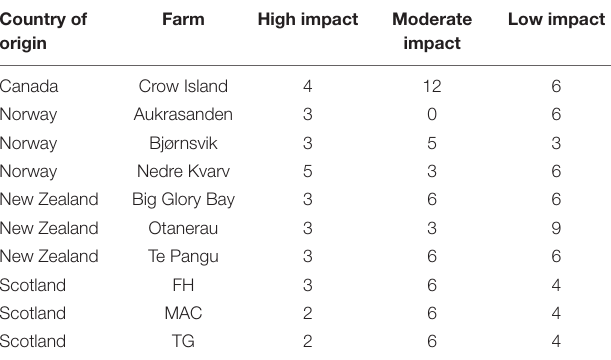
TABLE 1 | Overview of 138 samples from each farm under study and their assignments to aquaculture-related impact categories (high, moderate, and low). Country of